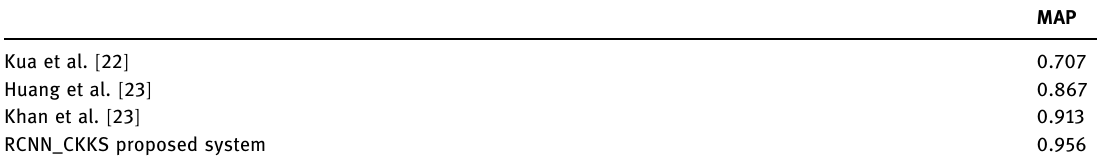
Table 12: Image retrieval map in CIFAR - 10